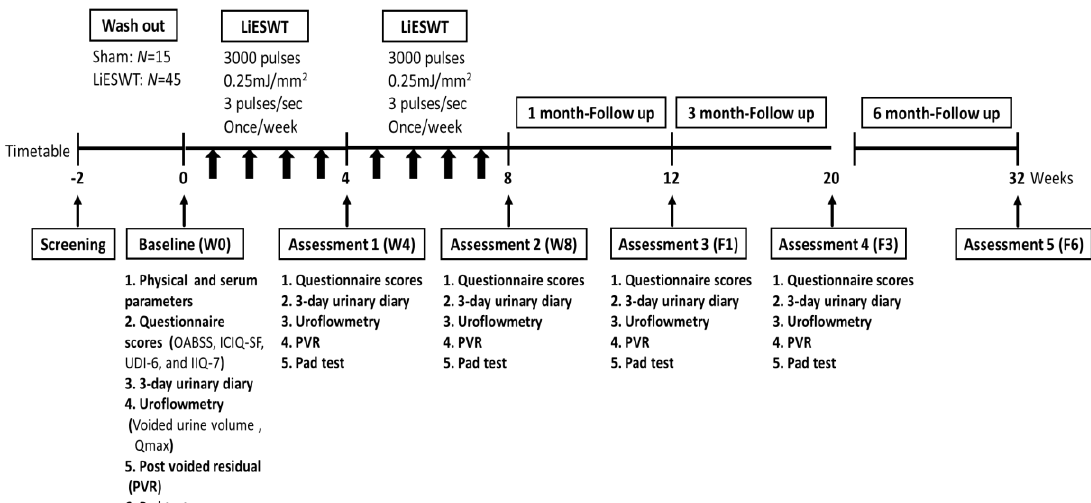
Figure 1. Timetable designed for the clinical trial of stress urinary incontinence (SUI). LiESWT: Low intensity extracorporeal shock wave therapy; W0: baseline; W4: 4-week; W8: 8-week; F1: 1-month; F3: 3-month; F6: 6-month; OABSS: Overactive Bladder Symptom Score; ICIQ-SF: International Consultation on Incontinence Questionnaire Short Form; UDI-6: Urinary Distress Inventory Short Form; IIQ-7: Incontinence Impact Questionnaire Short Form.